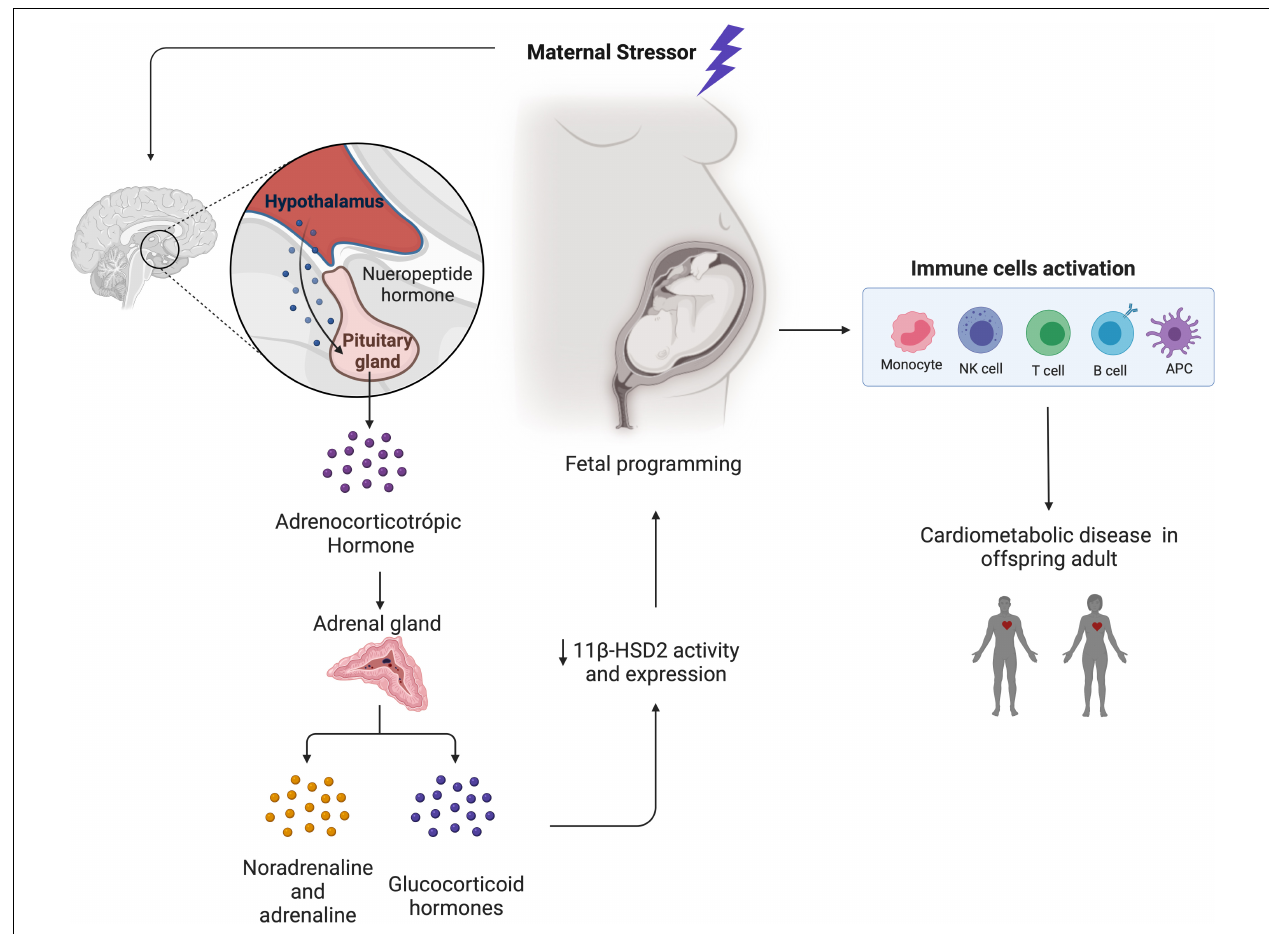
FIGURE 1 | Feedback between maternal stress-induced glucocorticoid production by HPA axis (hypothalamic–pituitary–adrenal axis) activation and fetal programming induced cardiometabolic disease in offspring